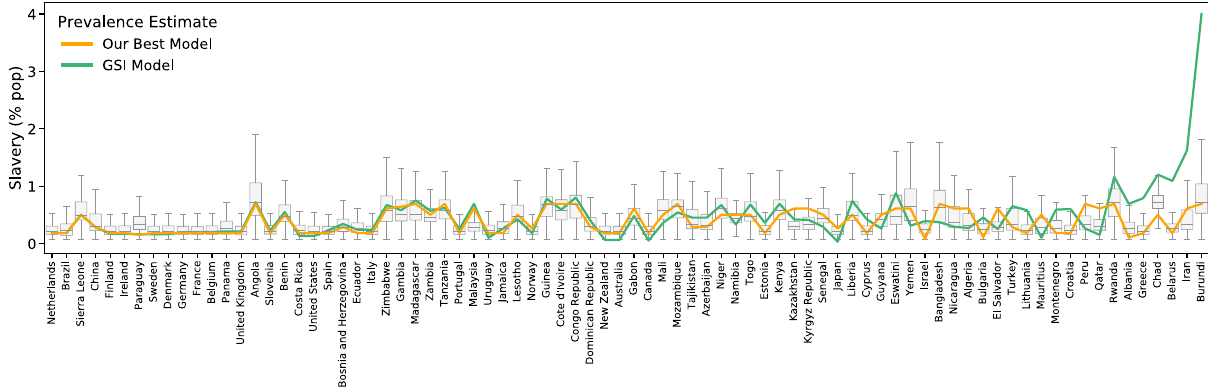
Fig. 8 The predictions made for the 2018 prevalence of slavery (individuals enslaved as a % of the population) in countries where no GWP survey data exists. The estimates made by the best performing model are compared to those made by the GSI. The grey box plots illustrate the distribution of 10,000 bootstrapped LOOCV predictions (using the full pipeline NMF → DT) to help illustrate the uncertainty associated with our model ’ s predictions. The box shows the quartiles of the bootstrapped predictions while the whiskers extend to show the rest of the distribution, except for points that were determined to be “ outliers ” (using a function of the inter-quartile range), which are not plotted. The x -axis is ordered by the disagreement between our model ’ s predictions and the predictions made by the GSI model. The countries displayed are those which had < 10% missing independent variable data. For all 172 out-of-sample predictions and information on missing data see the Supplementary Material, Table